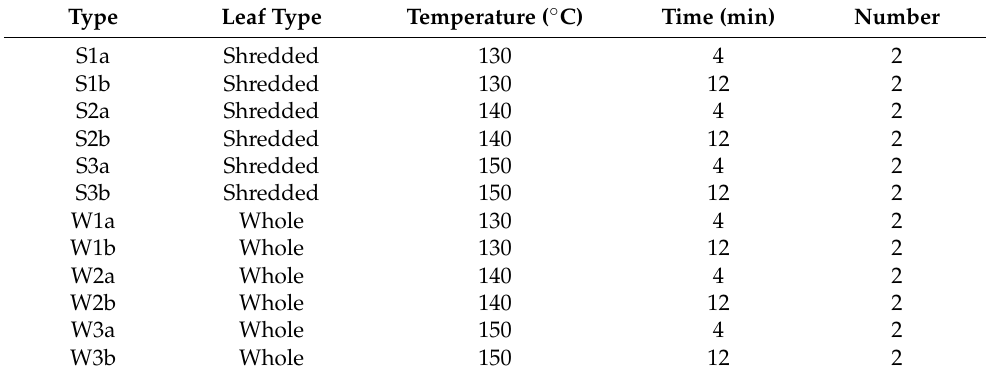
Table 1. Types of board